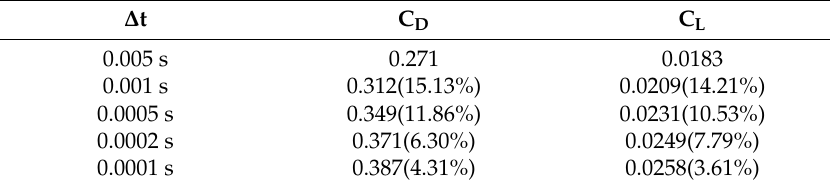
Table 2. The e ff ect of the iteration time step on the lift and drag coe ffi cients (Nm = 52,436). ∆ t C D C